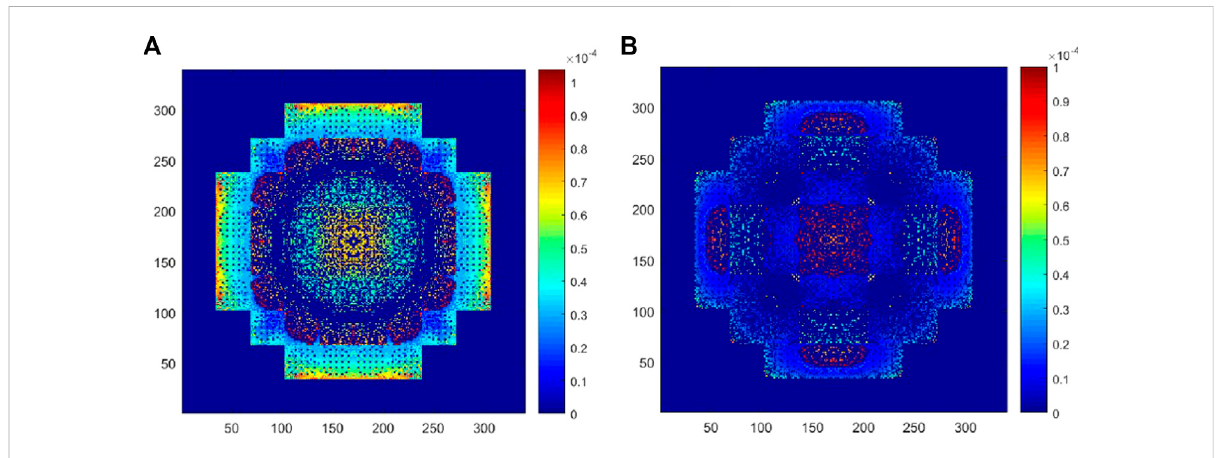
FIGURE 6 Relative error (%) of radial average power density between comePSn_JFNK and comePSn codes for 3-D KAIST-3A benchmark problems: (A) ARO and (B)